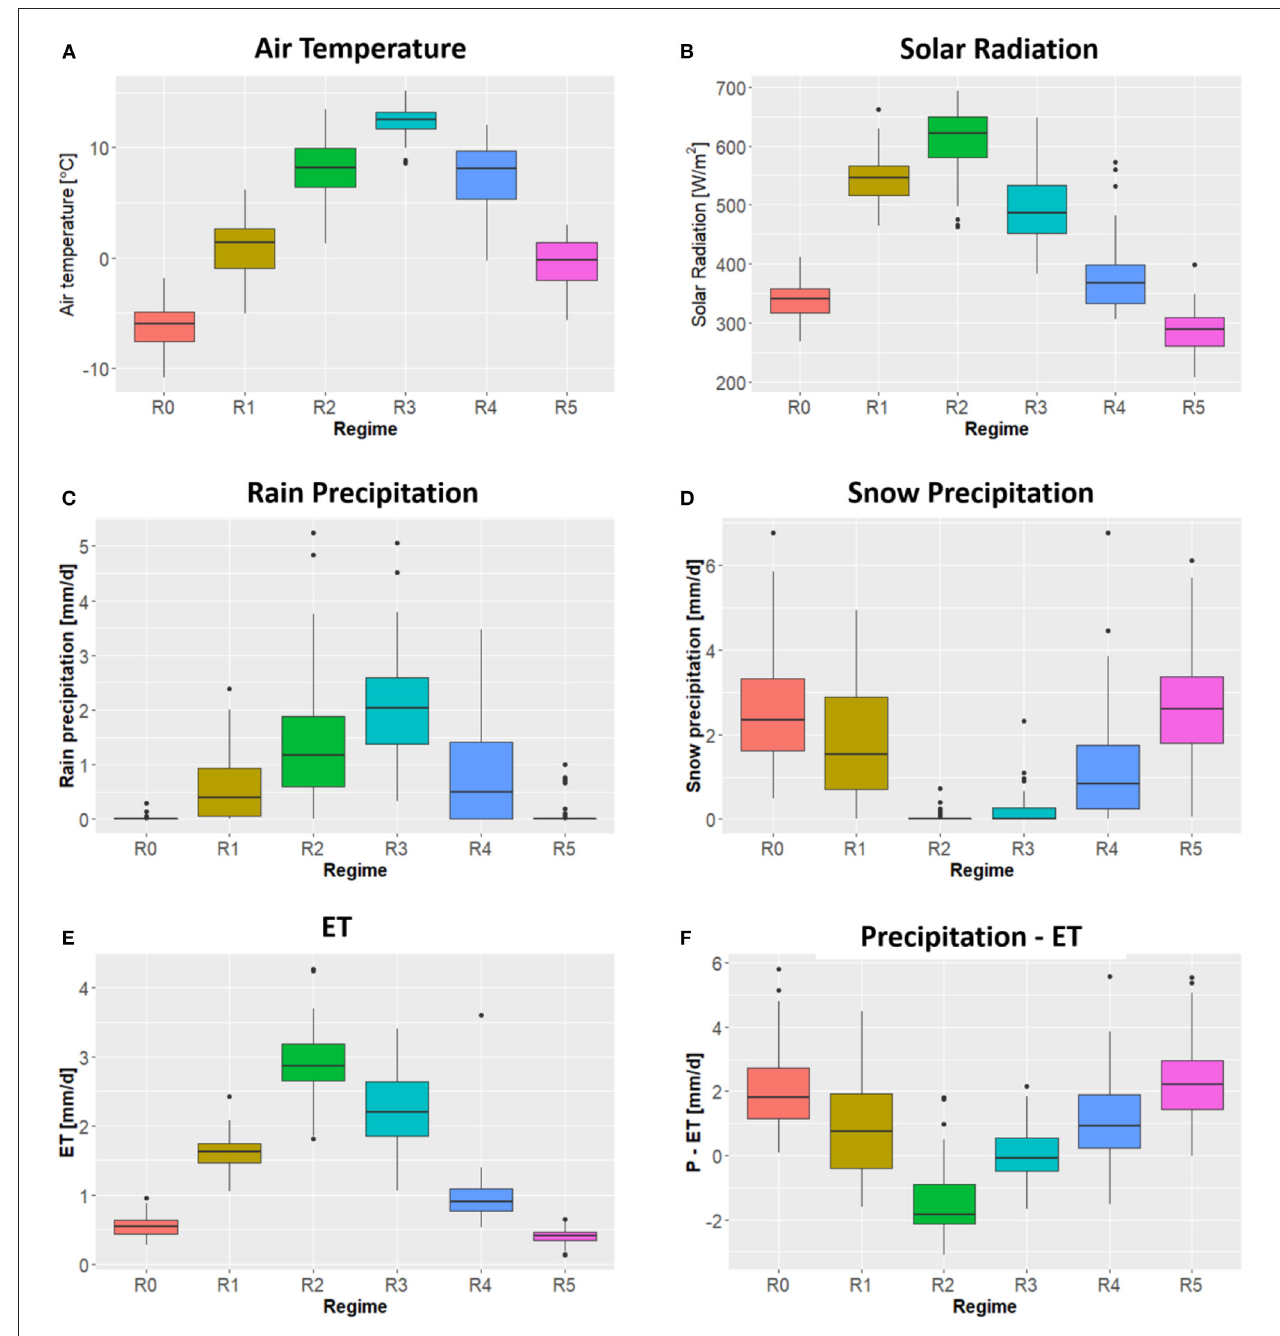
FIGURE 5 | Summary of subseasonal regime-based characteristics of daily air temperature (A) , solar radiation (B) , rain precipitation (C) , snow precipitation (D) , ET (E) , and precipitation minus ET (F) at all six sites in this study.